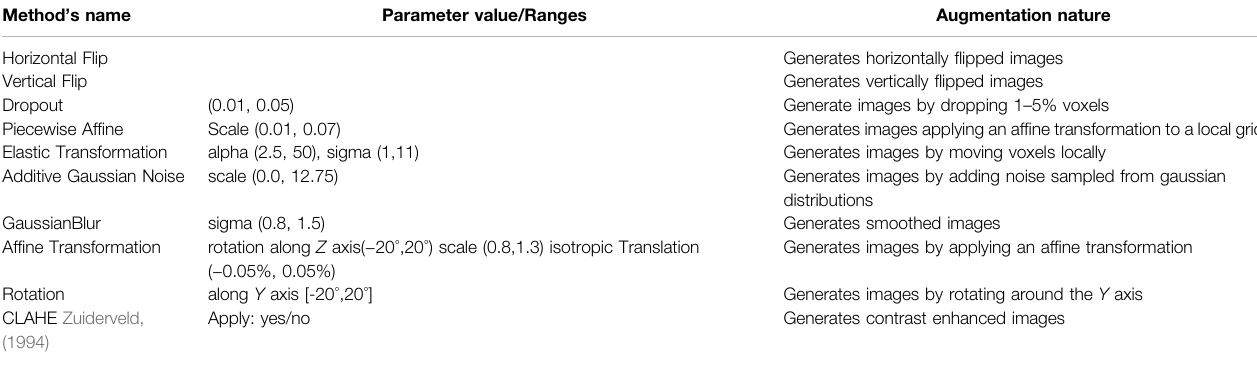
TABLE 1 | Data augmentation methods and parameters. Parameter values are chosen randomly from the sample space (square